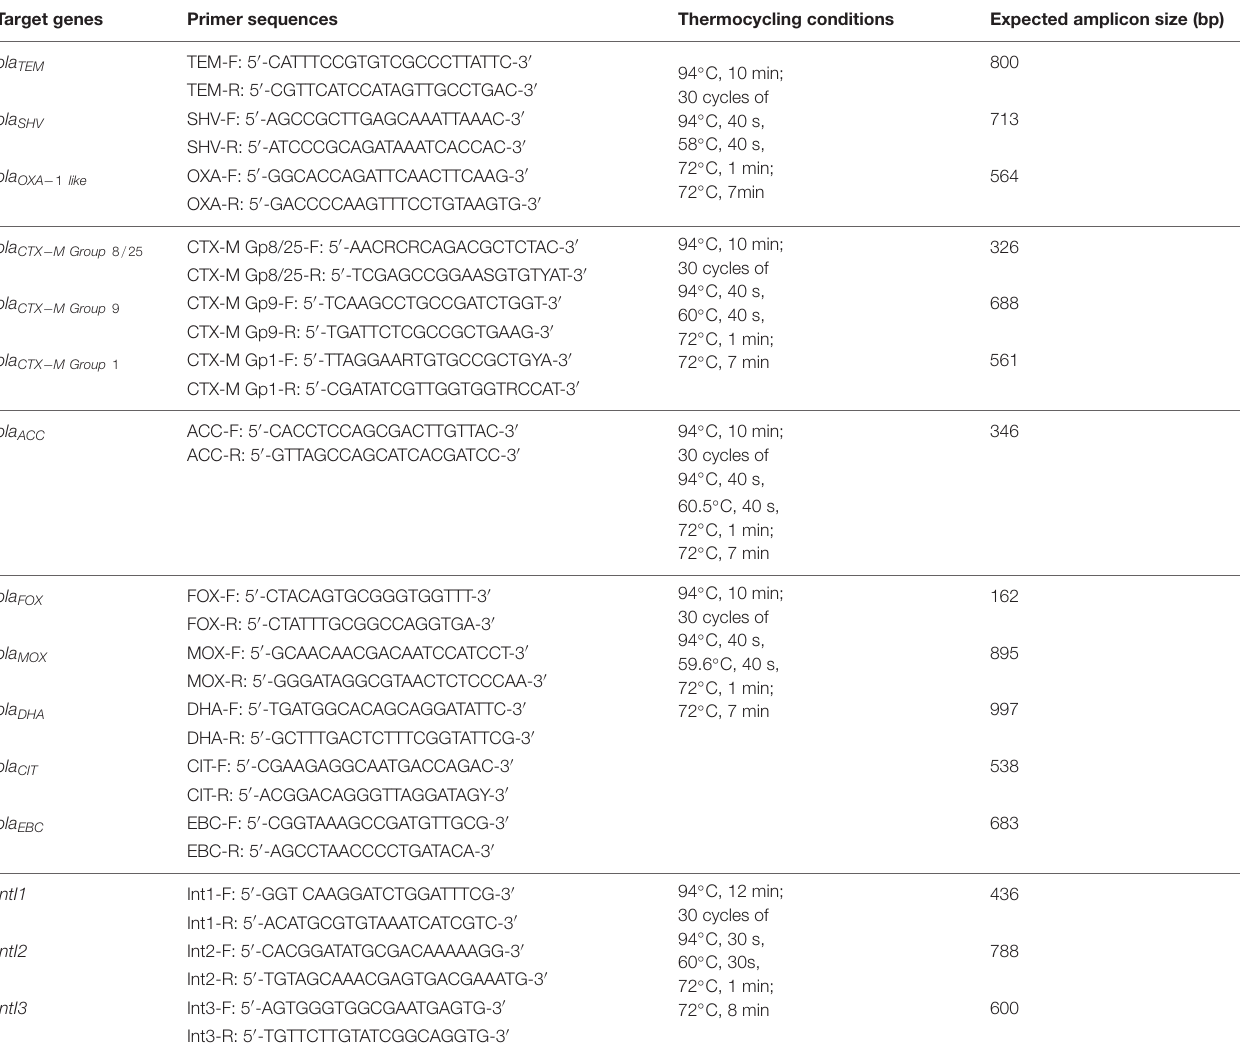
TABLE 1 | Primers used for screening of broad-spectrum β -lactamase, ESBL, and AmpC genetic determinants (Dallenne et al., 2010) as well as integron prevalence (de Paula et al., 2018) in selected Enterobacteriaceae isolated from water, fresh produce, and contact surfaces. Target genes Primer